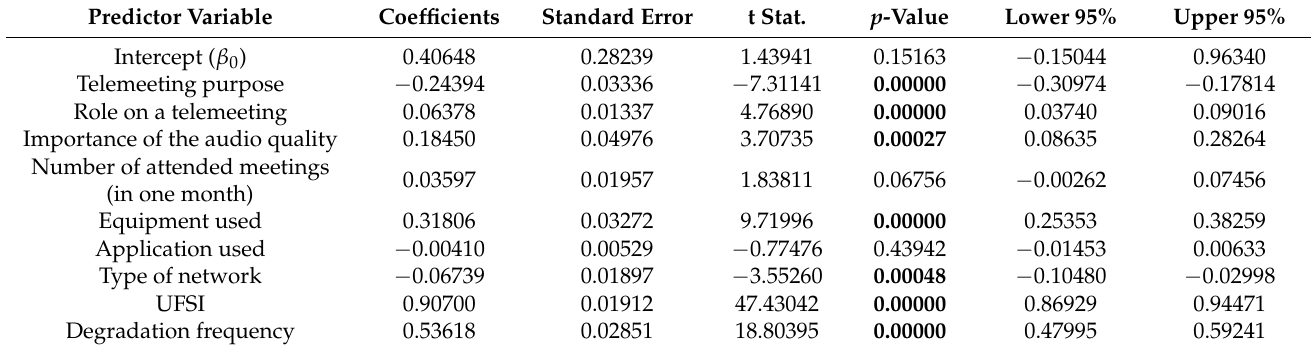
Table 12. Regression coefficients analysis for echo in the audio degradation.